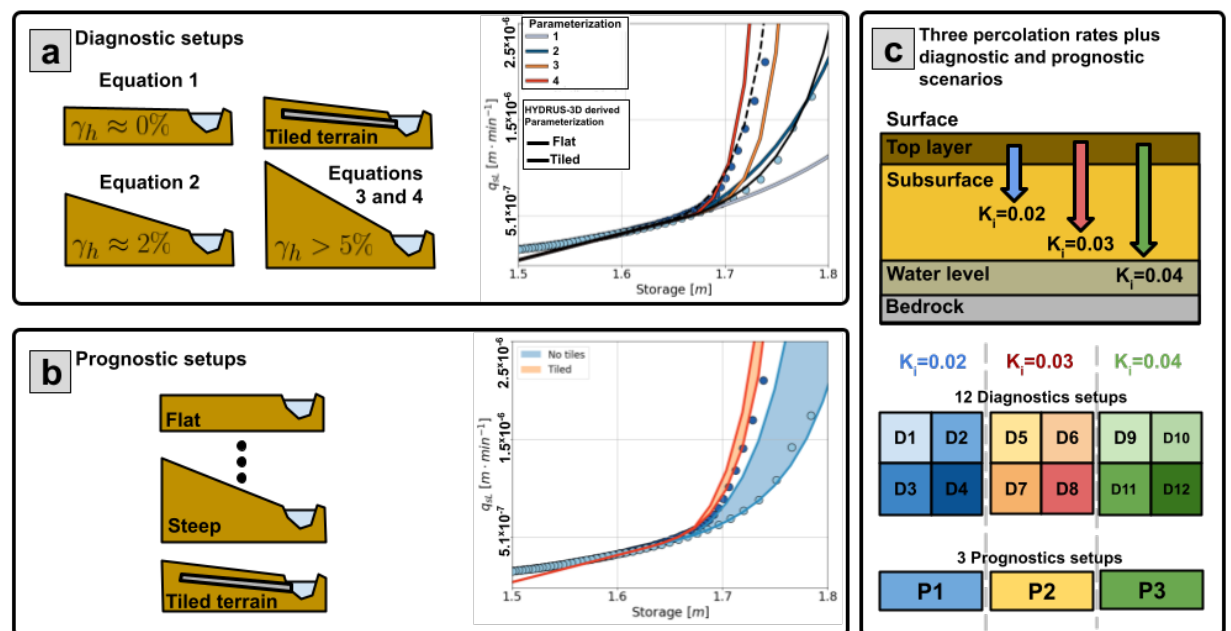
Figure 4. Diagnostic and prognostic experiment setup: ( a ) diagnostic case with four non-linear subsurface flux equations fixed for the domain of Iowa after [17] ( b ) prognostic case, with equations varying with the hillslopes steepness (blue scenario) and the presence of tiles (red scenario); and ( c ) percolation rates fixed for the different scenarios. Their combination gives us 12 diagnostic scenarios and three prognostic scenarios. Table 1. HLM diagnostic and prognostic setups